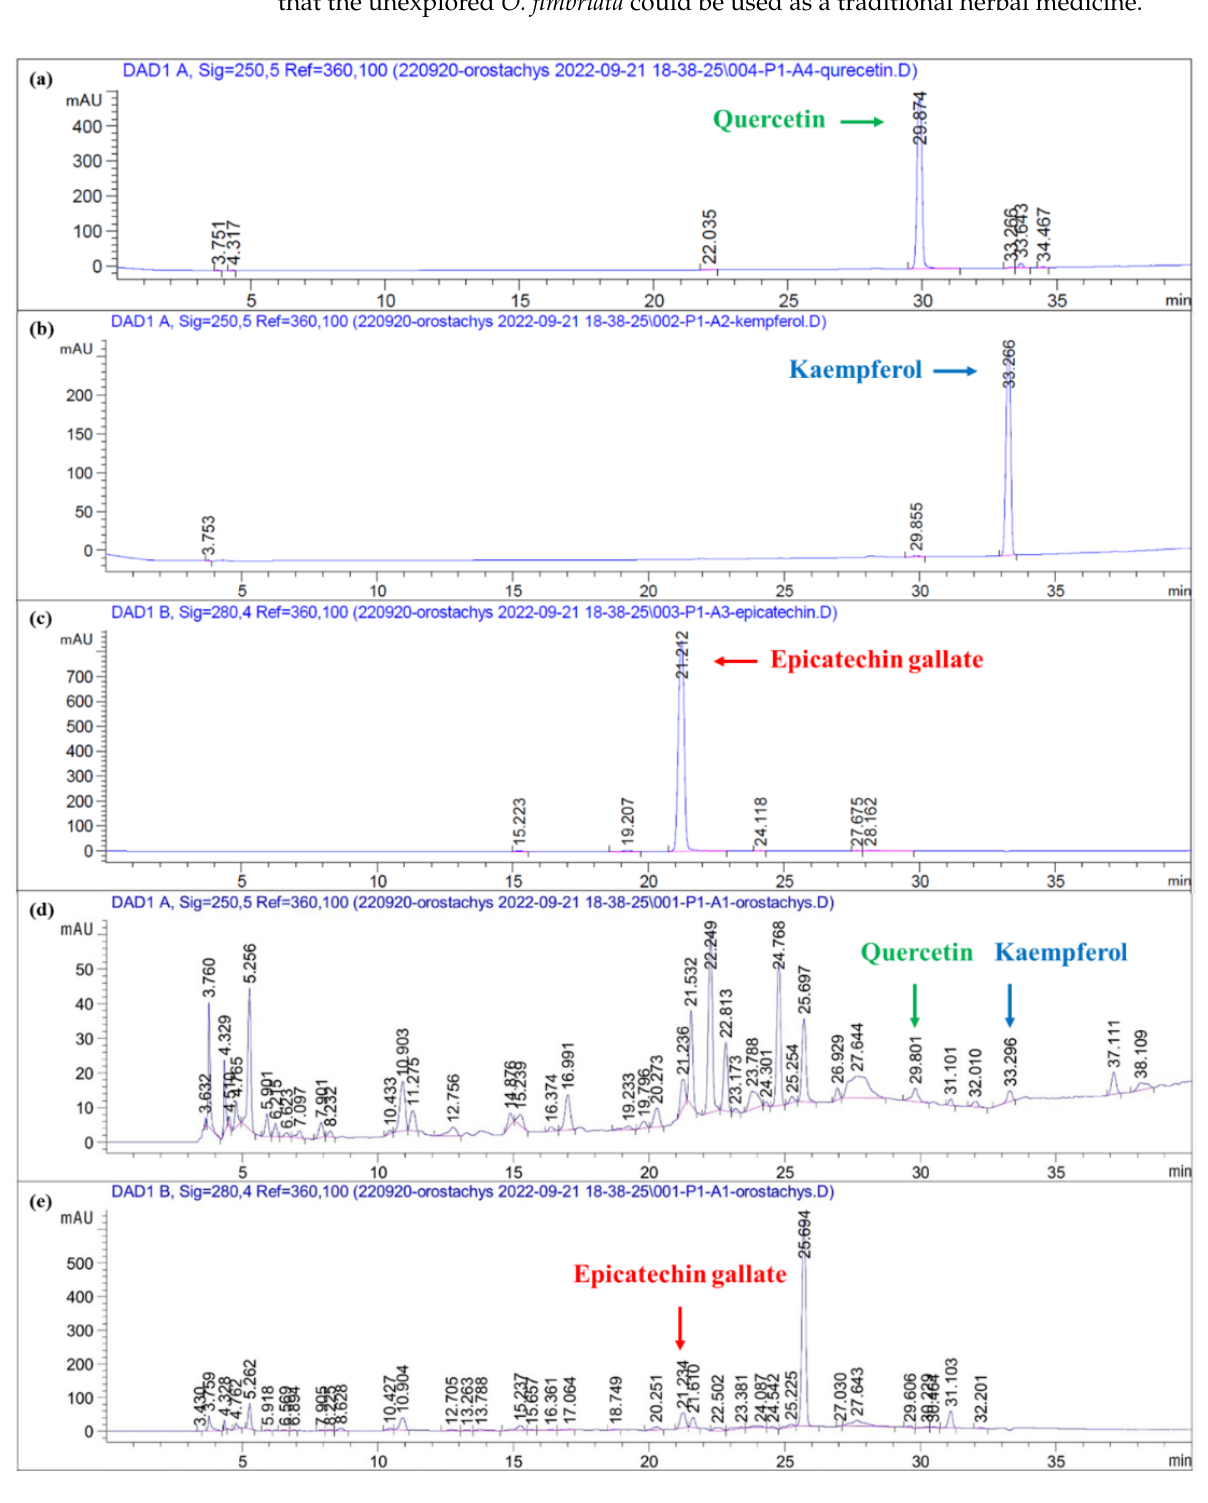
Figure 3. HPLC-DAD spectra for detection of quercetin standard ( a ), kaempferol standard ( b ), and epicatechin gallate standard ( c ) and these flavonoids in O. fimbriata extracts ( d , detected at 250 nm; e , detected at 280 nm).